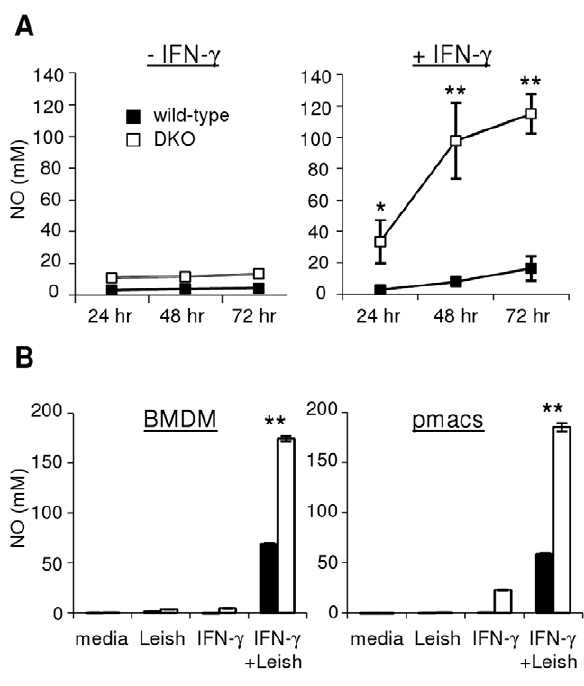
Figure 3. LXR-deficient macrophages produce increased levels of NO following exposure to Leishmania and IFN- c in vitro. A. BMDM from individual wild-type and DKO (Sv129xC57Bl/6) mice were stimulated in vitro with stationary-phase L. chagasi/infantum promas- tigotes for the times indicated, in the absence (left) or presence (right) of IFN- c pre-treament. B. BMDM (left) or peritoneal macrophages (right) from wild-type (solid bars) or LXR-DKO (empty bars) mice (C57Bl/6 background) were infected with stationary-phase L. chagasi/infantum (with or without IFN- c pre-treatment) for 24 hours in vitro . Supernatants were removed and levels of NO were quantitated by the Griess method. Error bars represent standard deviations of triplicate NO measurements. Results are representative of at least 3 independent experiments; * denotes p , 0.05, ** p , 0.005.